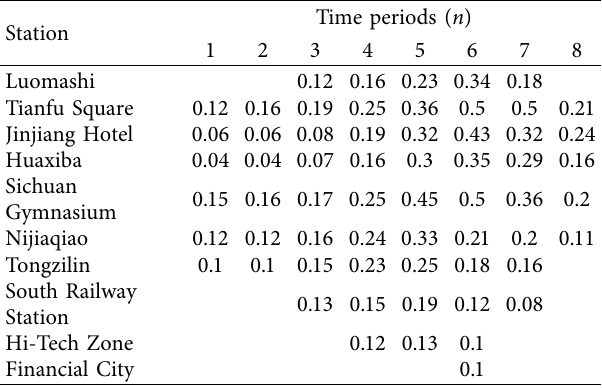
Figure 9: Convergence curve of the optimal values over iterations. Table 7: Control rates of the passenger inflows at different